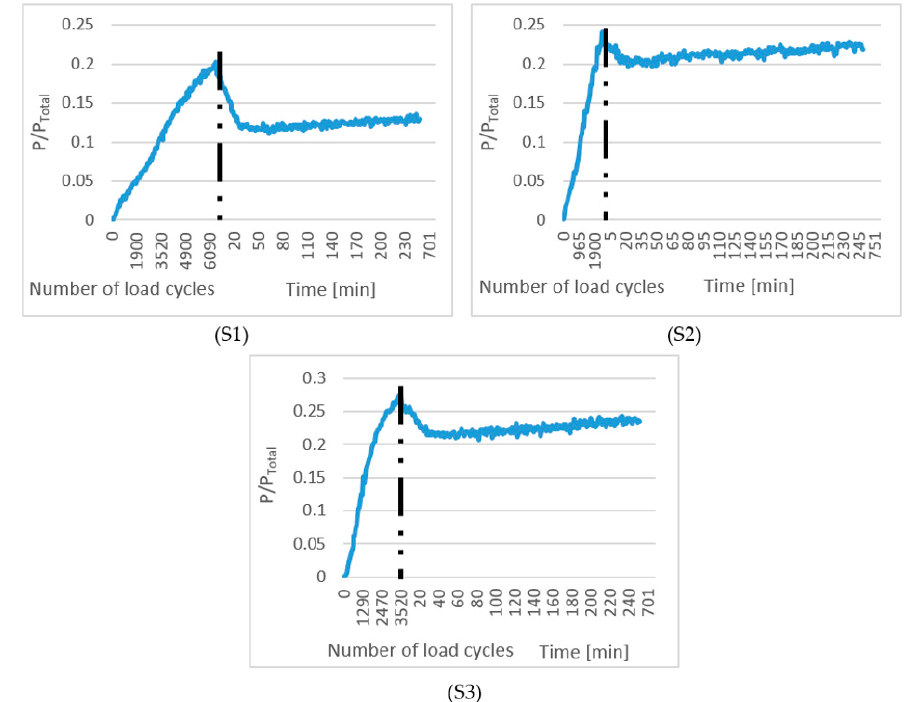
Figure 9. P / Ptotal calculated by digital image correlation (DIC) for three identical asphalt concrete specimens (S1 – S3). Table 3. Healing parameters of three identical asphalt samples using the data acquired by the UTM and DIC.